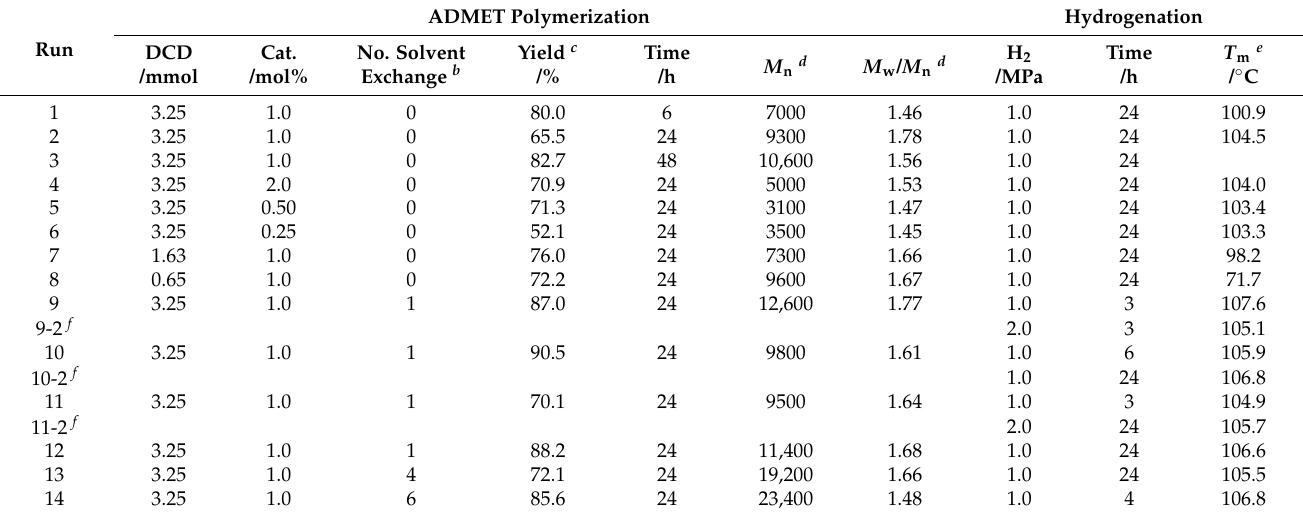
Table 1. ADMET copolymerization of M1 with 1,9 ‐ decadiene (DCD) a .